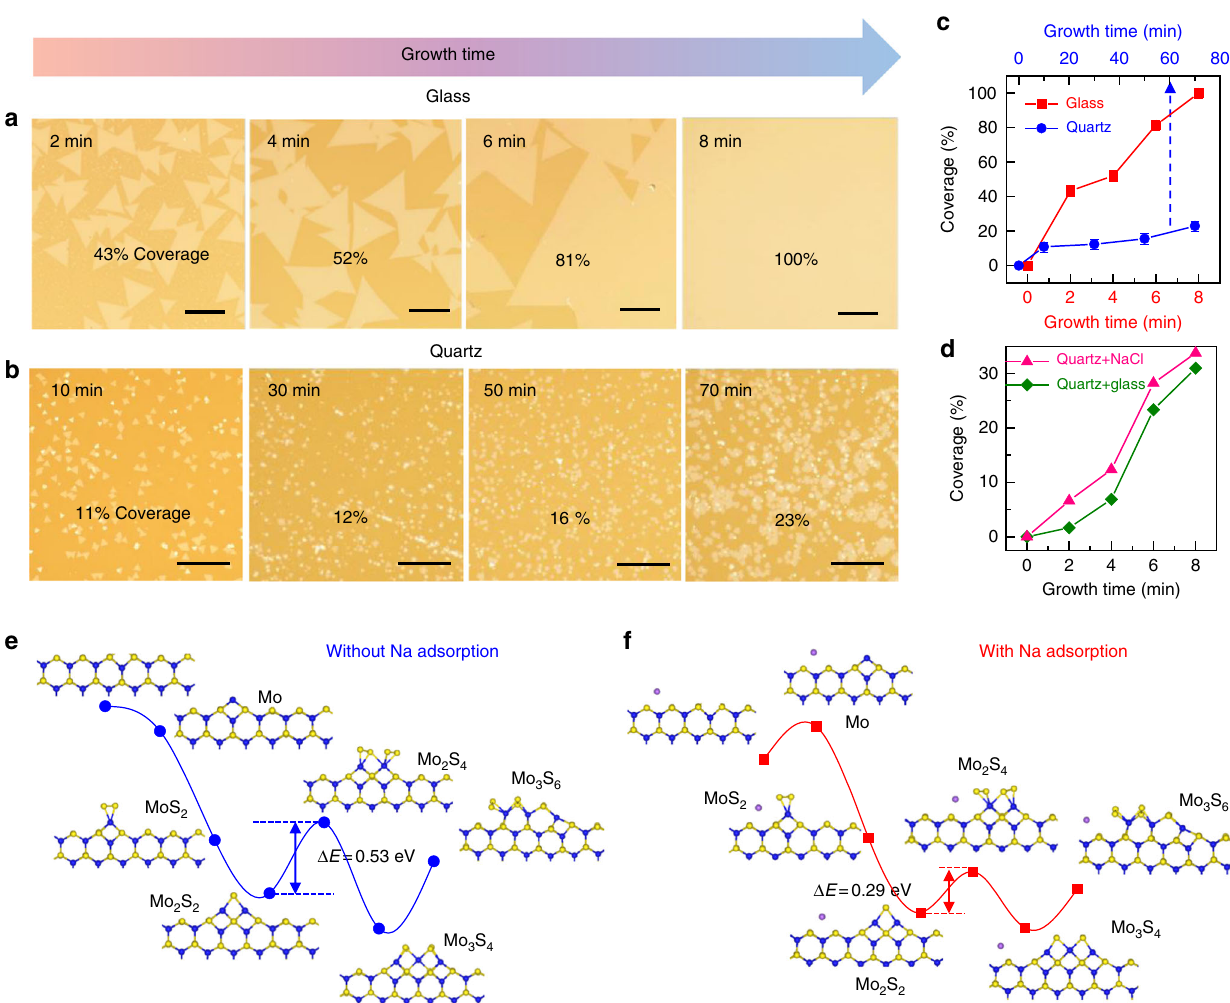
Fig. 3 The role of Na from soda-lime glass in promoting the growth rate of monolayer MoS 2 . Growth-time - dependent OM images of MoS 2 synthesized on a soda-lime glass with growth time from 2 to 8 min (scale bars: 100 µ m) and b quartz glass from 10 to 70 min (scale bars: 50 µ m). Other than the substrate type, all experimental parameters were identical for the samples shown in a and b . c MoS 2 coverage as a function of growth time on soda-lime glass (red) and quartz (blue). d MoS 2 coverage as a function of growth time on quartz substrates either placed downstream from the glass (green) or spin-coated with NaCl (pink) prior to growth. e , f DFT-calculated energy diagrams for MoS 2 growth along the S-terminated edges, e without and f with Na adsorption. The blue, yellow, and purple spheres represent molybdenum, sulfur, and sodium atoms,